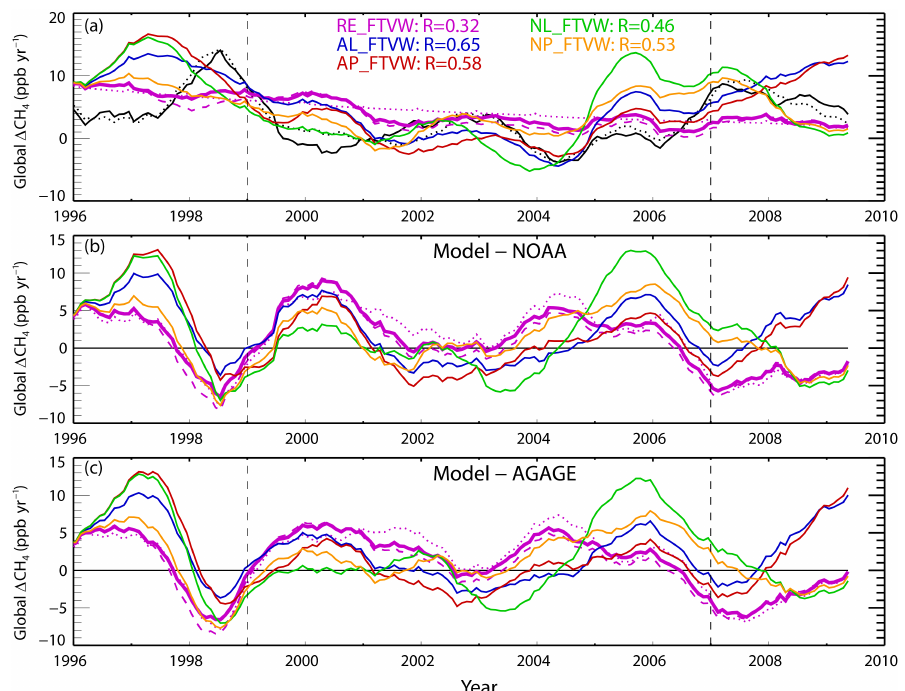
Figure 5. (a) The smoothed variation in the global annual CH 4 growth rate (ppbyr − 1 ) derived from NOAA (black solid) and AGAGE (black dashed) observations. Also shown are the smoothed growth rates from five TOMCAT 3-D CTM simulations with fixed temperatures and varying winds (FTVW; see Table 1). Values in legend give correlation coefficient between model run and NOAA observations. Also shown are results from runs RE_FTFW and RE_VTVW as a purple dotted line and dashed line, respectively. (b) The difference in smoothed growth rate between TOMCAT simulations and NOAA observations shown in panel (a) . (c) Same as (b) except using differences compared to AGAGE observations. The vertical dashed lines mark the start and end of the stagnation period in the observed CH 4 growth rate (1999–2006).